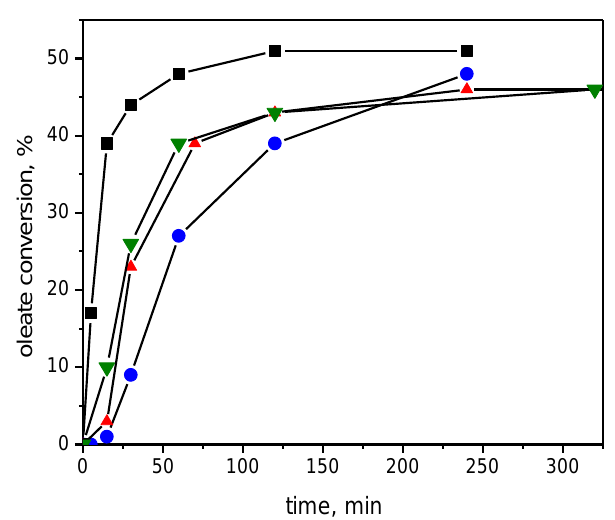
Figure 7. Self-metathesis of methyl oleate over 4.9a /SBA-15 ( ■ ), 4.9a /MCM-22 ( ▲ ), 4.9a /MCM-56 ( ▼ ), and 4.9a /MCM-36 (●). Toluene, 60 °C, molar ratio oleate/Ru = 250, c MeOl =0.15 mol/L. Taken from Reference [83].